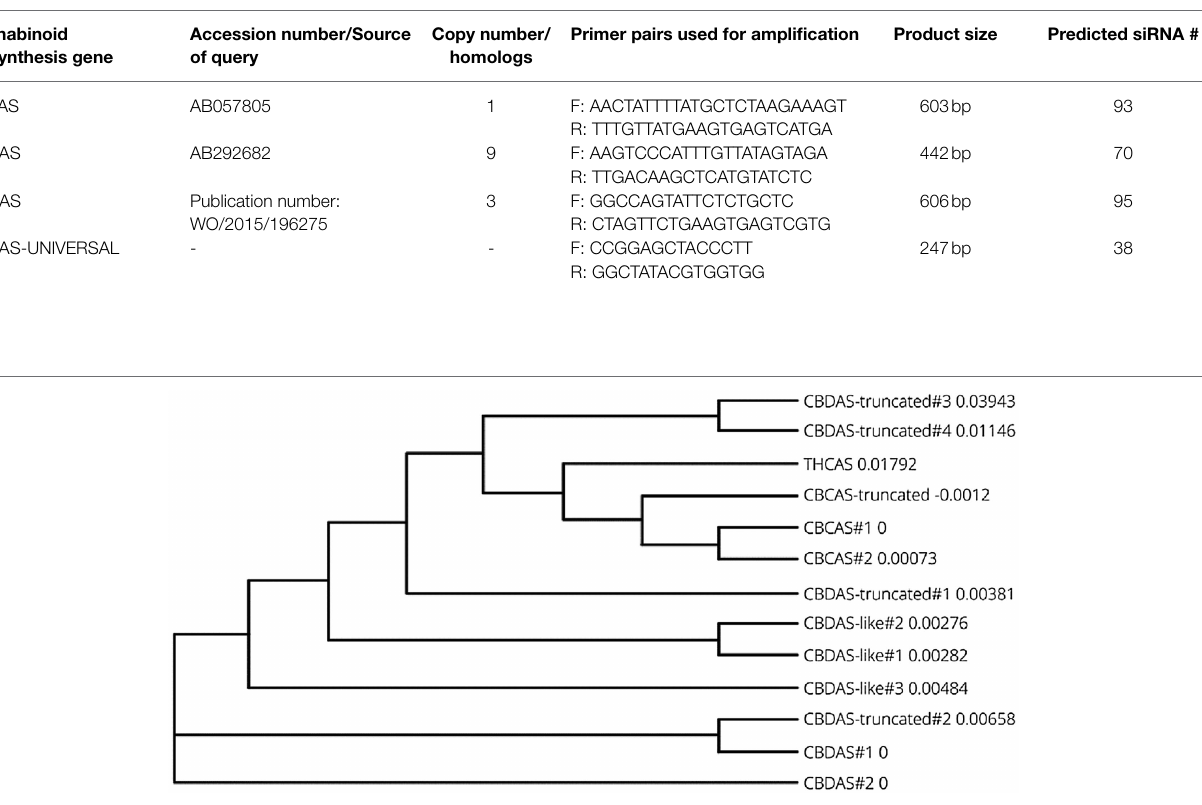
FIGURE 1 | Phylogenetic tree of coding sequence data from cannabinoid biosynthesis genes in Cannbio-2 displaying highly homologous nature of gene